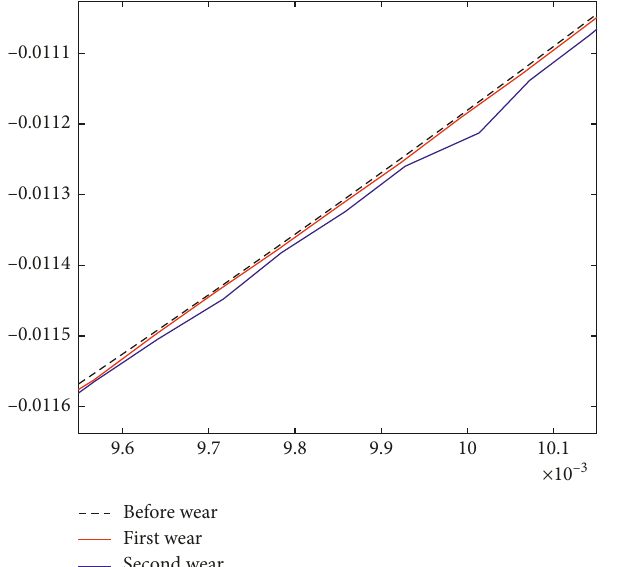
Figure 14: Local enlarged drawing of the bearing surface of joint B .